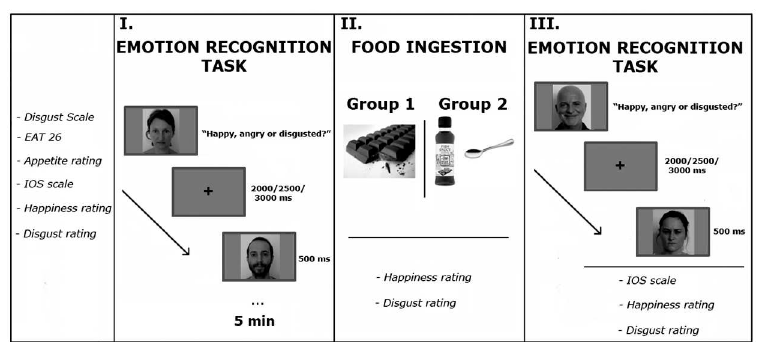
Fig 1. Visual representation of the Experimental Procedure. In an initial phaseparticipantswere asked to fill out two questionnaires and to perform four rating judgments. I. First session of the Emotion Recognition Task. II. Food ingestion: one group of participants was asked to eat ~5gr of dark chocolate,whereasthe other group was asked to ingest a spoonful of fish sauce. After food intake participantswere asked to perform an emotionintensity judgment. III. Secondsession of the Emotion RecognitionTask, followedby another emotionintensity judgment and IOS rating scale. The faces depicted in this figure are not the originalones from the KDEF dataset, but are mere examples. The individualshave given written informed consent (as outlinedin PLOS consent form) to publishtheir